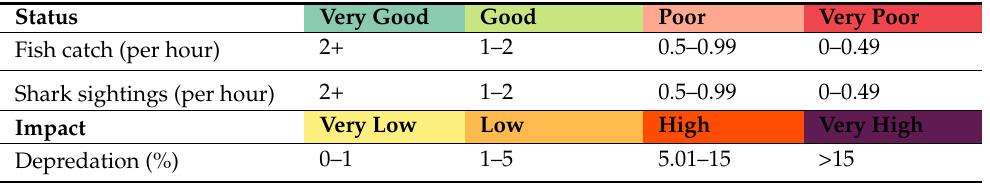
Table 2. Indicators for assessing status of fish catch (per hour) and shark sightings (per hour) and impact of shark depredation (categories based on grading categories from GBRMPA 2019). Status Very Good Good Poor Very Poor